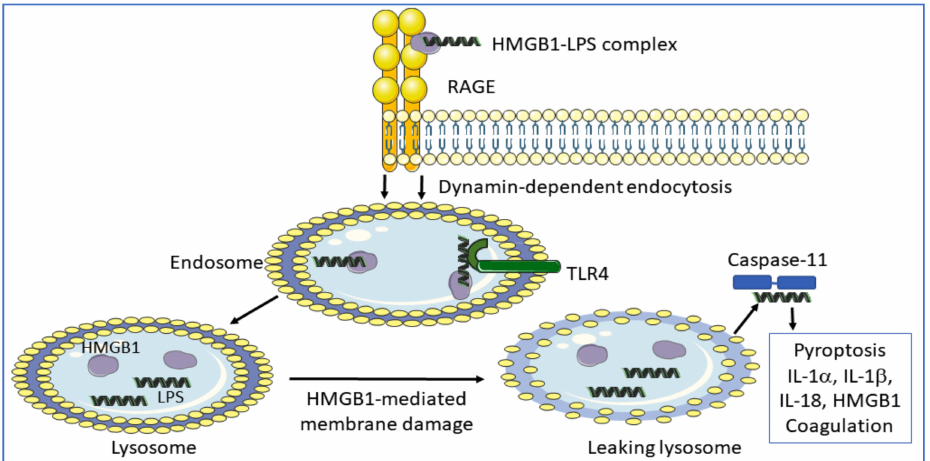
Figure 4. LPS needs HMGB1 to trigger severe inflammation. Injected LPS and type 1 interferon, (which generates HMGB1 release) in TLR4 gene-deficient mice is lethal in contrast to when adminis- tered to caspase-11 knockout mice [75,76]. The initial event in LPS toxicity is due to extracellular LPS activation of cell surface TLR4, which triggers extracellular HMGB1 release. HMGB1 has two LPS- binding sites (Figure 1) and thus forms extracellular HMGB1-LPS complexes that get endocytosed via RAGE to finally reach the cytosol culminating in caspase-11 activation (in mice; caspases 4/5 in humans) causing inflammation and